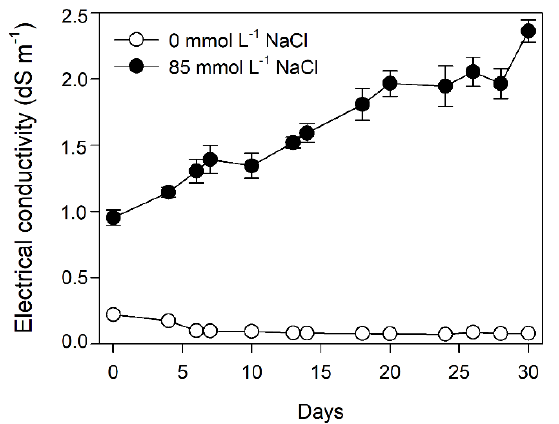
Figure 1. Electrical conductivity of Swiss chard plants grown at 0 and 85 mmol L − 1 NaCl. Each value represents the mean of six replicates ±SE.